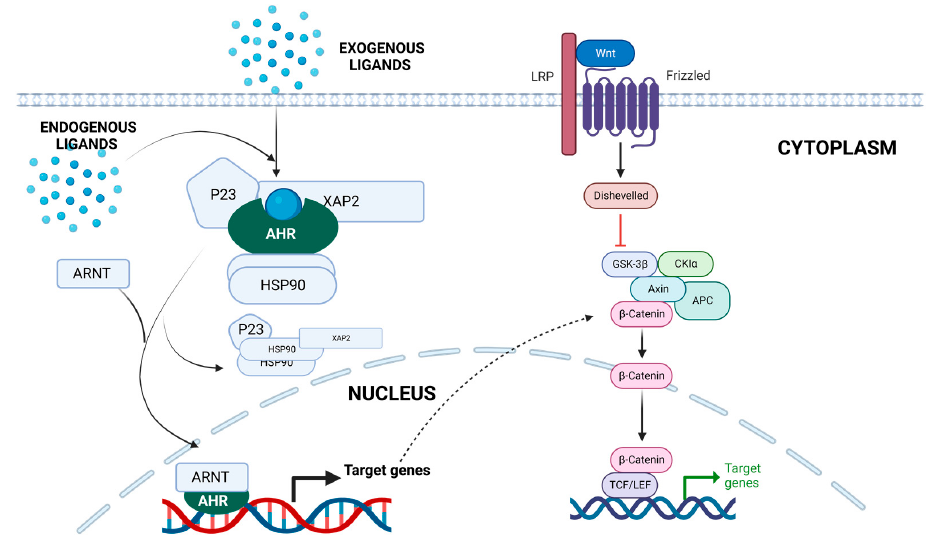
Figure 2. The Aryl Hydrocarbon Receptor (AhR) pathway. When inactive, the AhR is located in the cytoplasm and forms a complex with XAP2, also known as AIP, two HSP90 molecules, and p23. After ligand interaction, AhR translocates to the nucleus, interacting with ARNT to create a heterodimer. The heterodimer binds to the XRE and coregulators, leading to the transcription of target genes. AhR crosstalk with the Wnt pathway is also displayed. Figure created with Biorender.com.